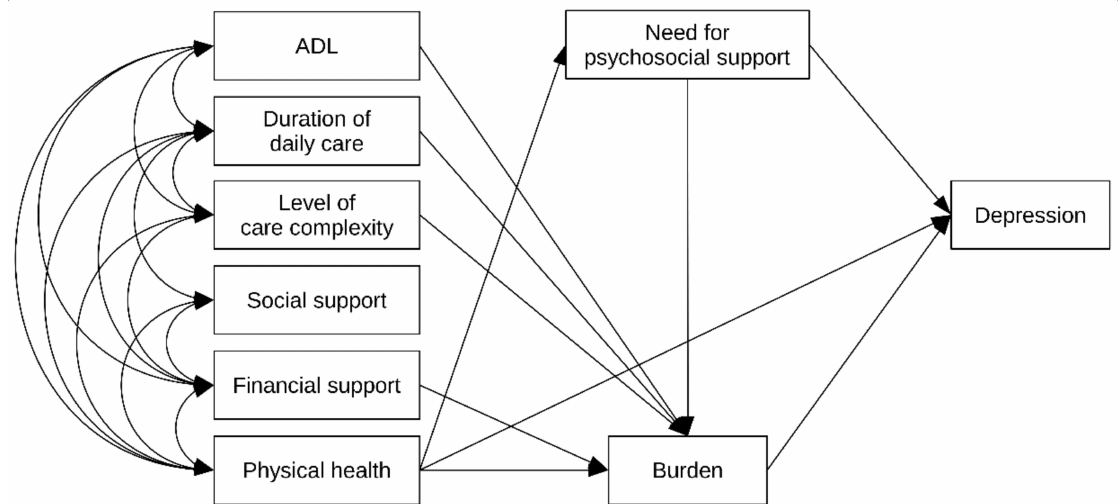
Figure 2. Path model presenting the complex relationship between the multiple determinants of the caregiving process, caregiver burden, and depression during the COVID-19 pandemic. ADL activities of daily